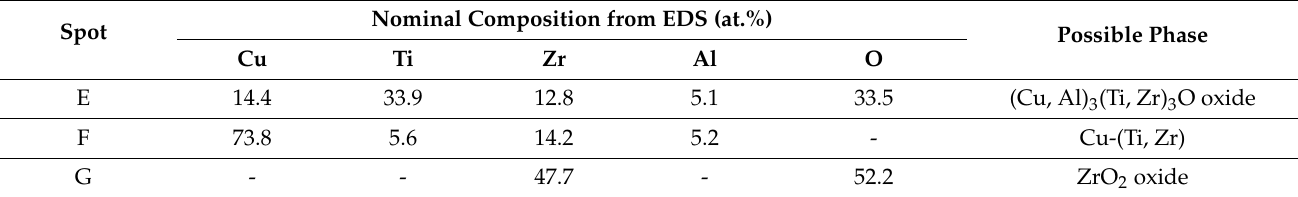
Table 3. Average elemental composition of reaction products in Figure 6c. Nominal Composition from EDS Spot